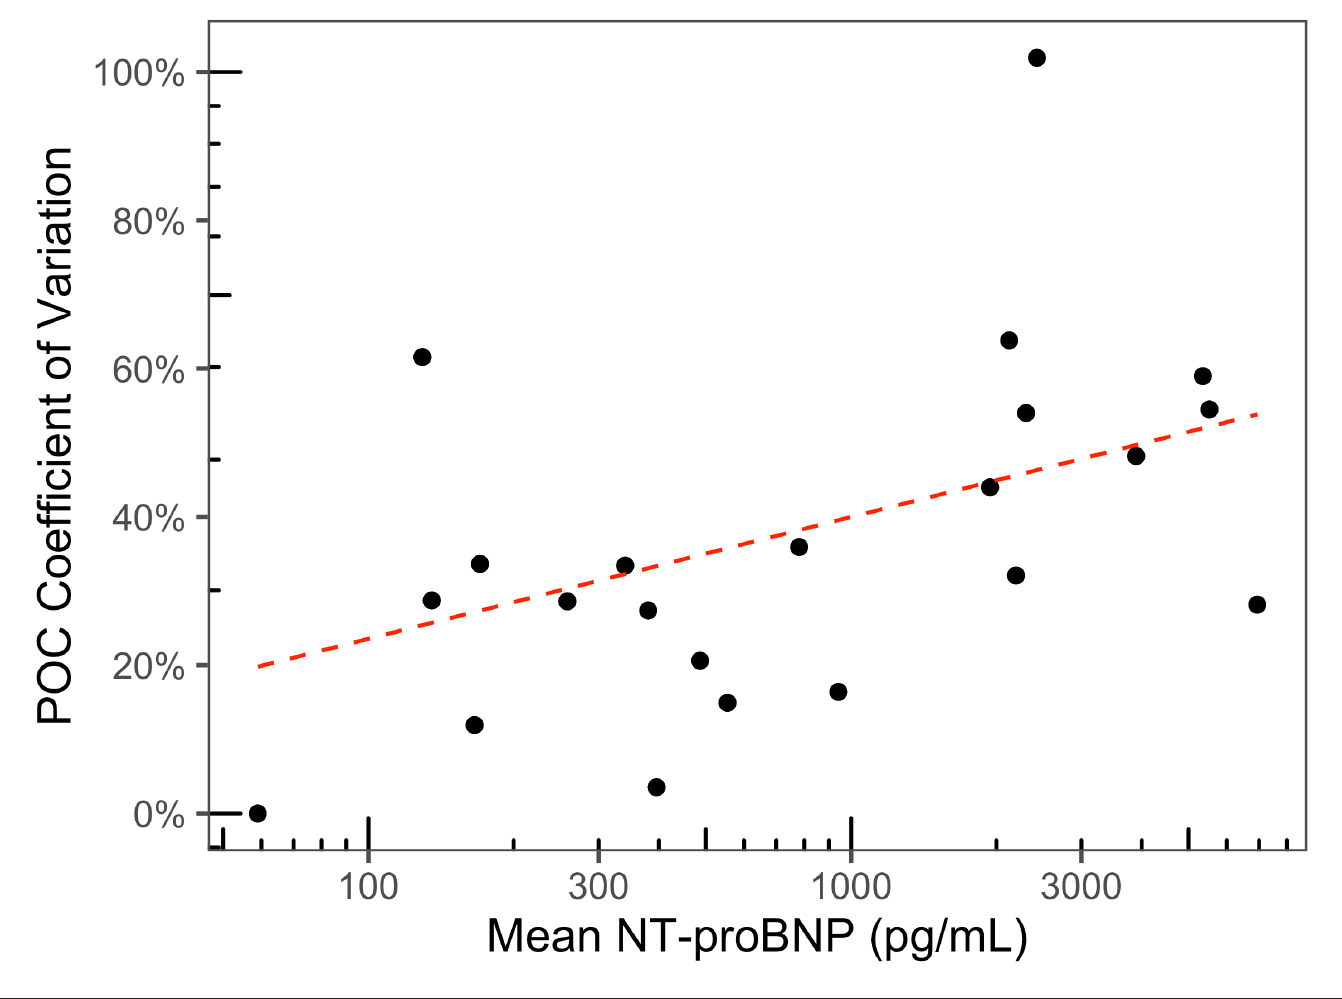
Figure 2 Coefficient of variation (CV) is calculated for the set of point- of- care (POC) N- terminal pro- B- type natriuretic peptide (NT- proBNP) readings for each patient, plotted against the mean POC NT- proBNP reading for each patient. CV increases with the mean NT- proBNP